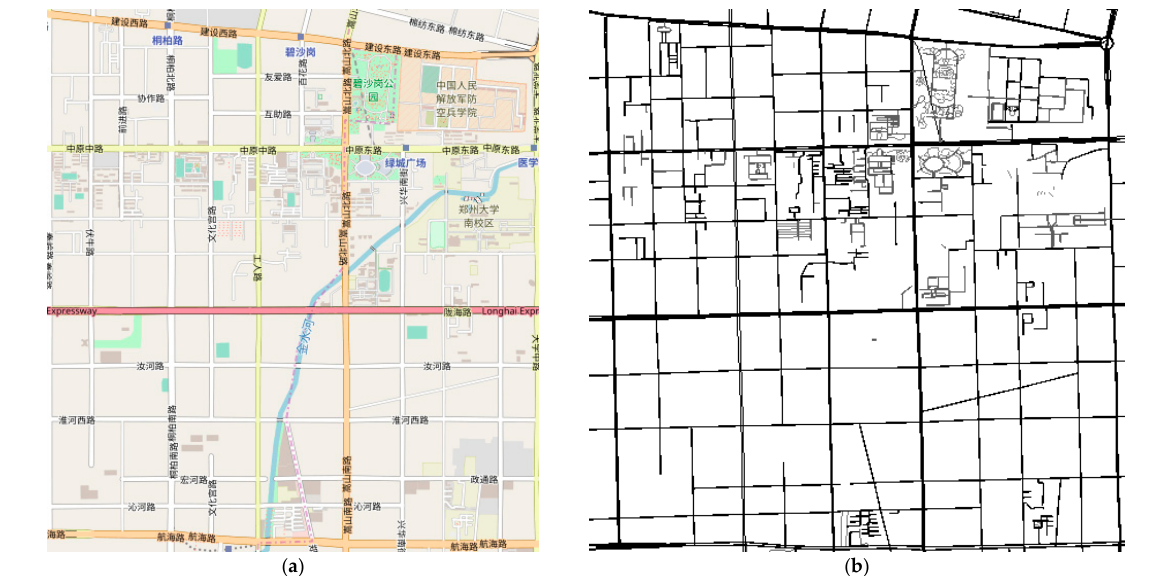
Figure 8. Erqi District, Zhengzhou, China. ( a ) Real map in OSM (Chinese characters in the map just show the name of the roads and area landmarks); ( b ) initial graph in SUMO.